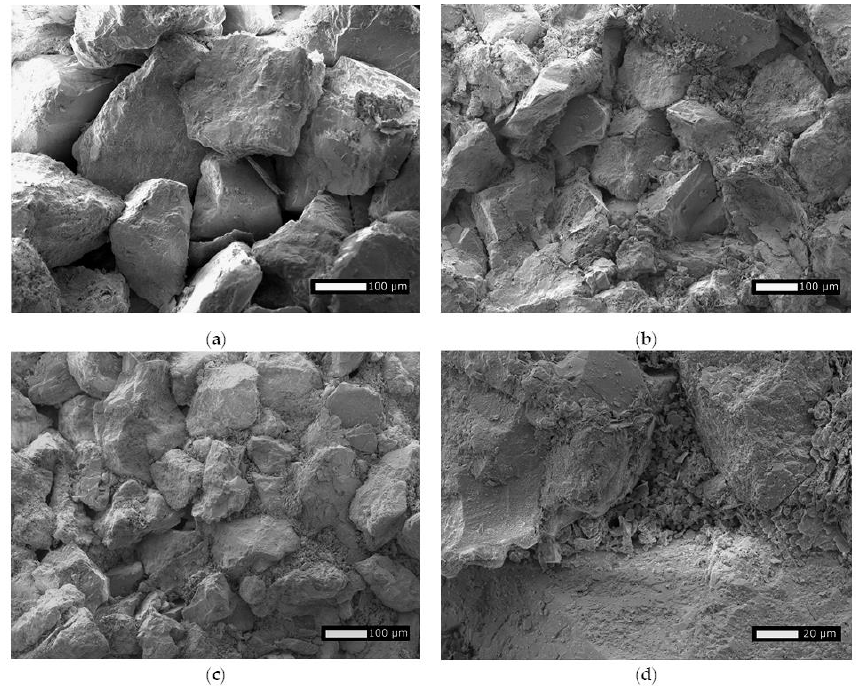
Figure 14. Scanning electron microscopy (SEM) images of samples from different Petrophysical Rock Types (PRT) groups in the same resolution: ( a ) PRT-4; ( b ) PRT-3; ( c ) PRT-2; and ( d ) shows a pore throat that is entirely filled with authigenic smectite in a sample from PRT-2.